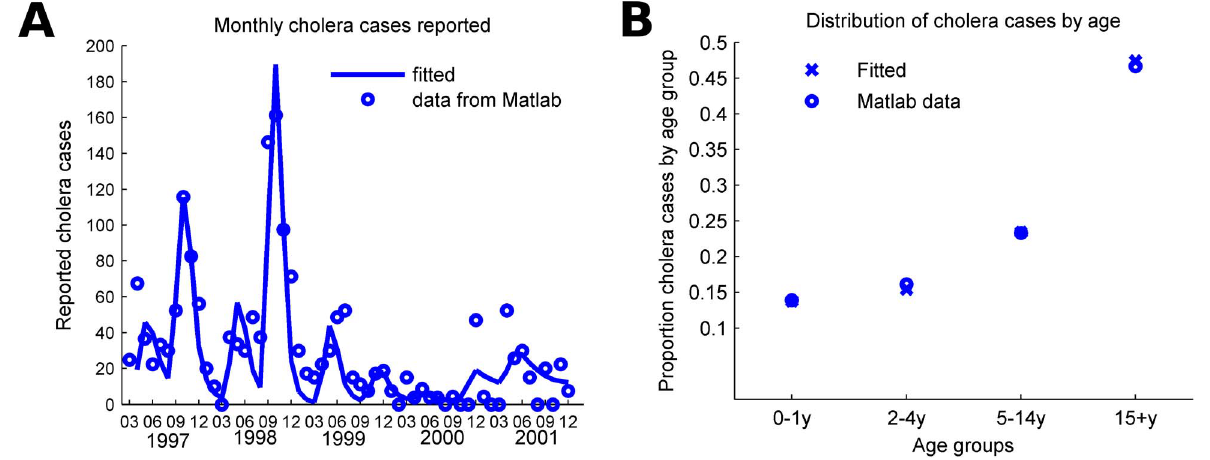
Figure 2. The mathematical model was calibrated to fit both the seasonal dynamics and the age distribution of cases in Matlab, Bangladesh. A) Reported cholera cases per month in Matlab, Bangladesh from March 1997 to December 2001. B) Distribution of the reported cholera during this period by age group.